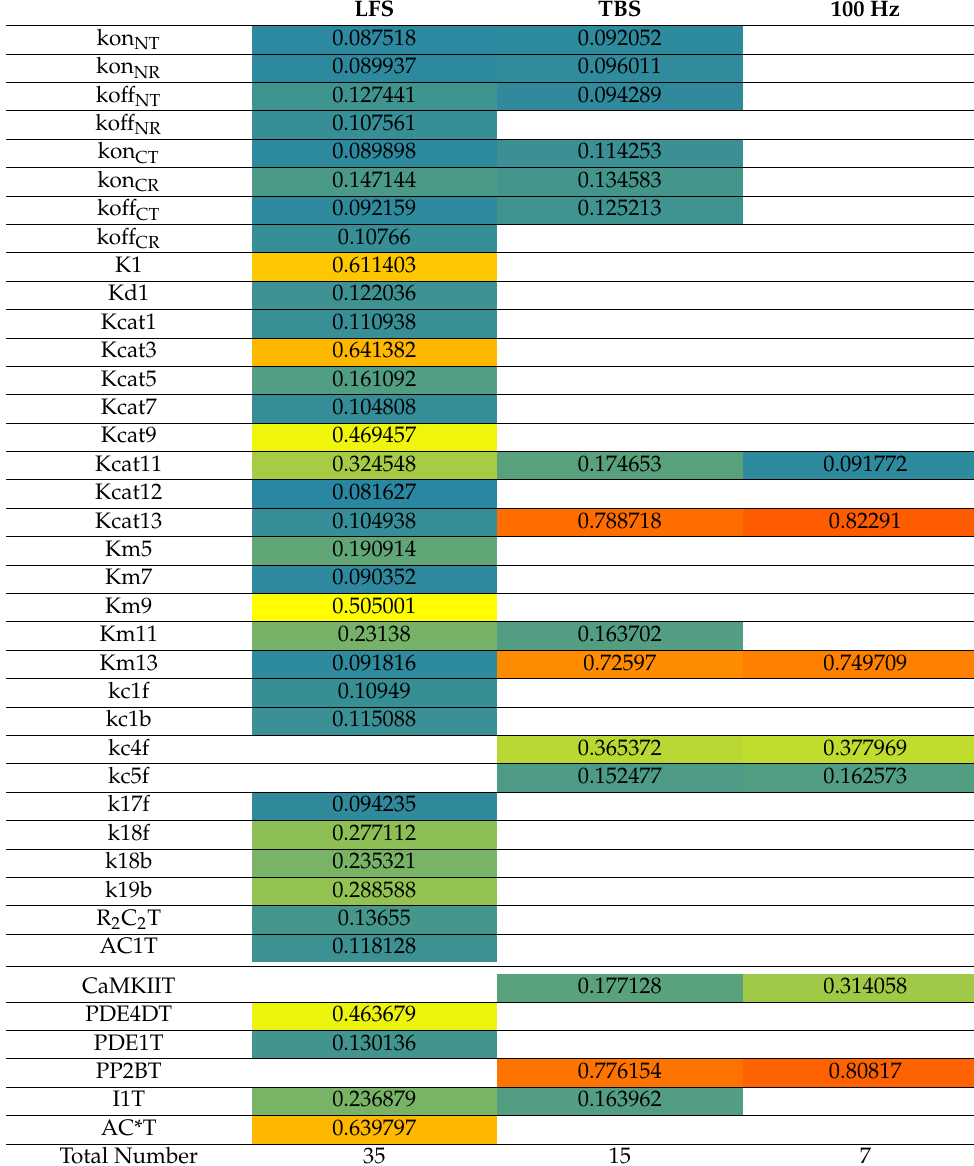
Table 6. GSA for I1PP formation. Each row represents a model parameter and its PRCC at each of the three stimulations. Empty cells represent no significant PRCC value ( p < 0.0001). The color indicates the significance of PRCC values: Blue is low significance; Green is moderate significance; Yellow is high significance; and Red means very strong